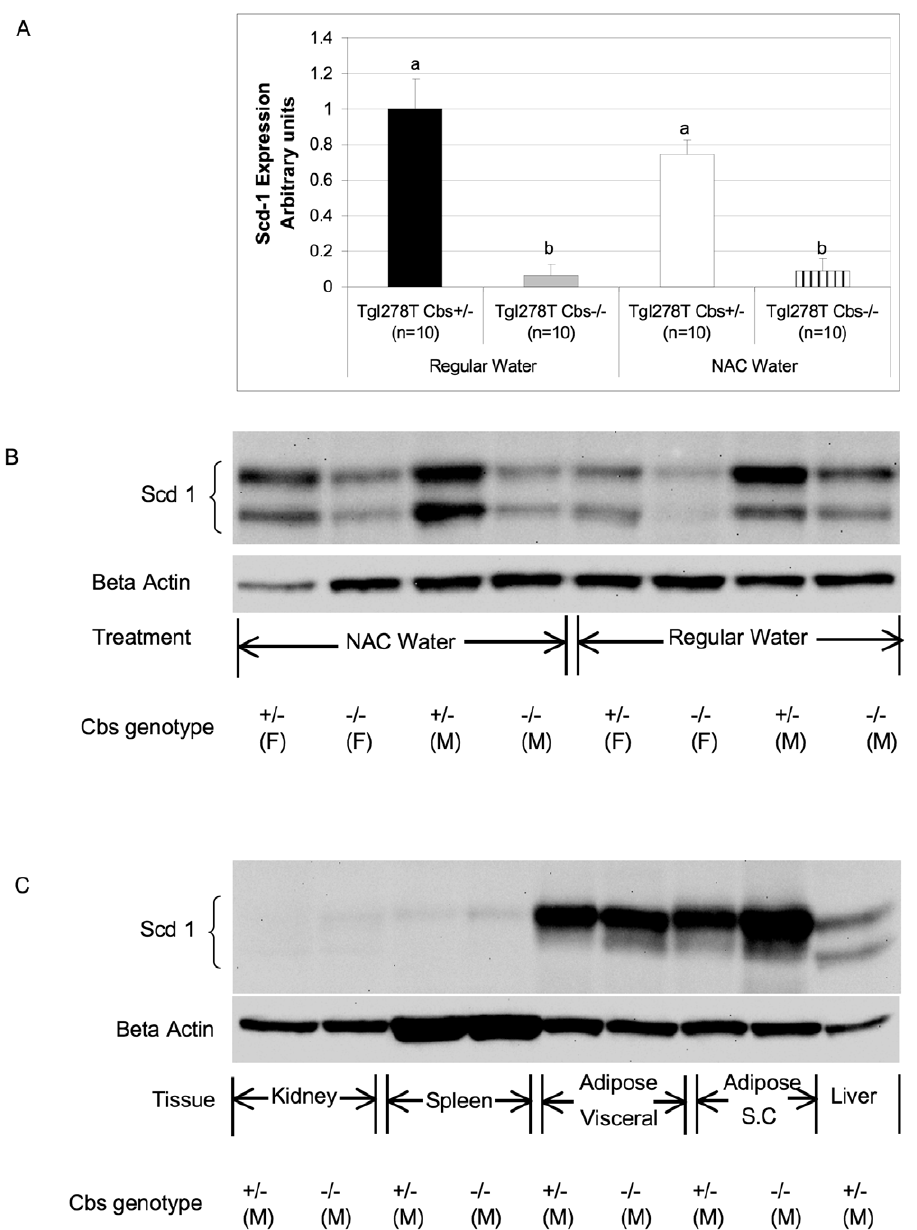
Figure 5. Effect of CBS genotype and NAC treatment on SCD-1 levels. ( A ) Liver Scd-1 mRNA levels assessed by qRT-PCR. All four groups include 5 males and 5 females that are exactly 240 days of age. Graphs show the mean 6 SD. Having different letters at the top of the error bar indicates significant differences between columns; ( B ) Liver SCD-1 protein levels as assessed by Western blotting. SCD1 runs as a doublet centered at 37 kDa. ( C ) SCD-1 expression in kidney, spleen, visceral, and subcutaneous fat from ( Tg-I278T Cbs + / 2 ) and Cbs deficient ( Tg-I278T Cbs 2 / 2 )